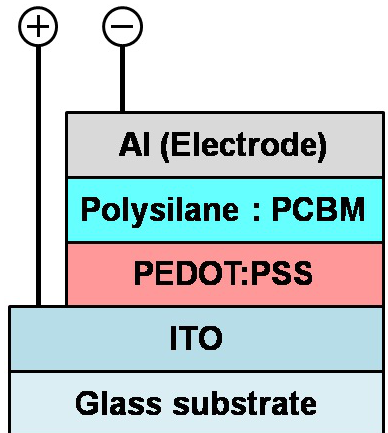
Figure 2. Schematic structure of polysilane:PCBM bulk heterojunc- tion solar